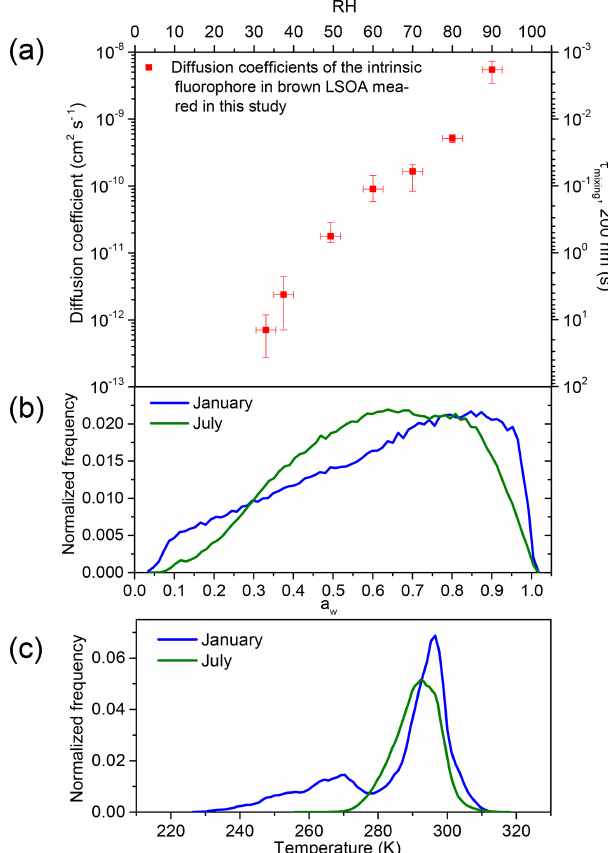
Figure 4. (a) Measured diffusion coefficients of the intrinsic fluo- rophore in brown LSOA as a function of a w (primary x axis) and RH (secondary x axis). The secondary y axis shows the mixing time, which is the time that would be needed for intrinsic fluo- rophores to mix within a 200nm brown limonene particle. The y error bars correspond to the highest and lowest diffusion coefficient measured. The x error bars correspond to uncertainty of the RH measurements ( ± 2 . 5%). (b) The a w distribution in January (blue line) and July (green line) in the planetary boundary layer (PBL) when monthly averaged concentrations of organic aerosol (OA) are > 0 . 5µgm − 3 at the surface based on GEOS-Chem. (c) The temper- ature distribution in January and July in the PBL when monthly av- eraged concentrations of OA are > 0 . 5µgm − 3 at the surface based on